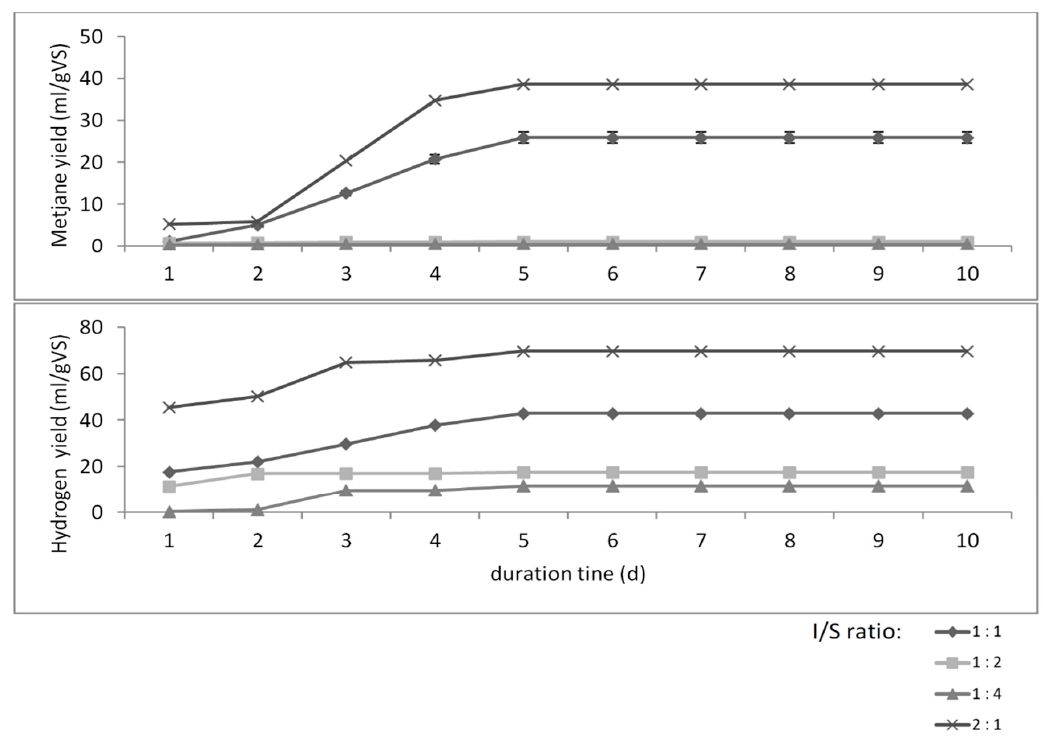
Figure 5. Cumulative hydrogen and methane productions during hyperthermophilic treatment of leaves at 70 °C. Table 2. Operating parameters and performances of the experiments with biogas production. Grass Leaves I/S 2:1